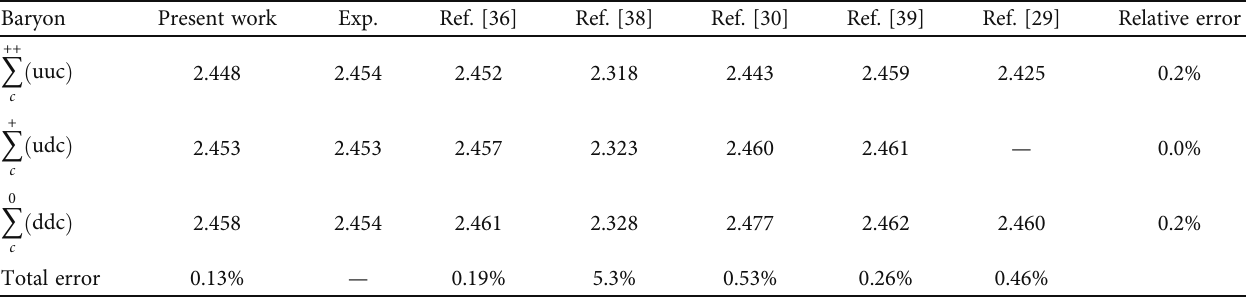
Table 3: Single charm baryon masses in the ground state (masses are in GeV) at ( α = β =0.665). The last column shows the relative error in comparison to experimental data.